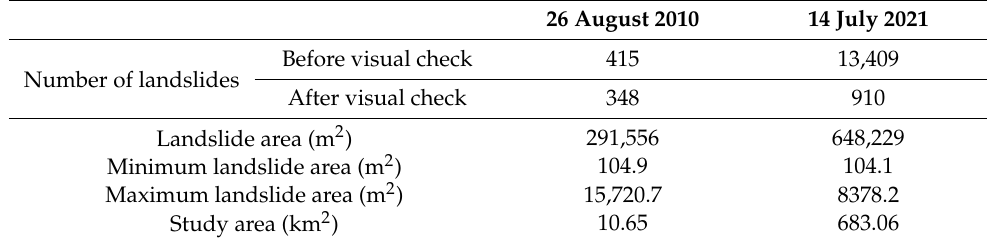
Figure 5. Landslide distribution map (yellow and red lines indicate each landslide area; satellite image is acquired from PlanetScope [30]). Table 2. Landslides that occurred in 2010 and 2021.